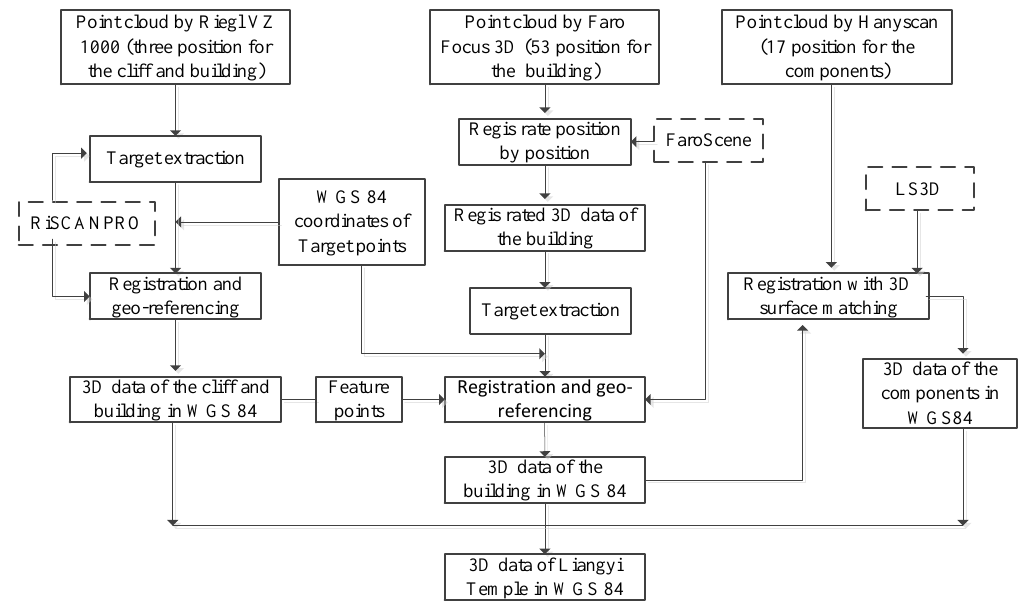
Figure 8. 3D Data registration approach for the point cloud of a different scanner.